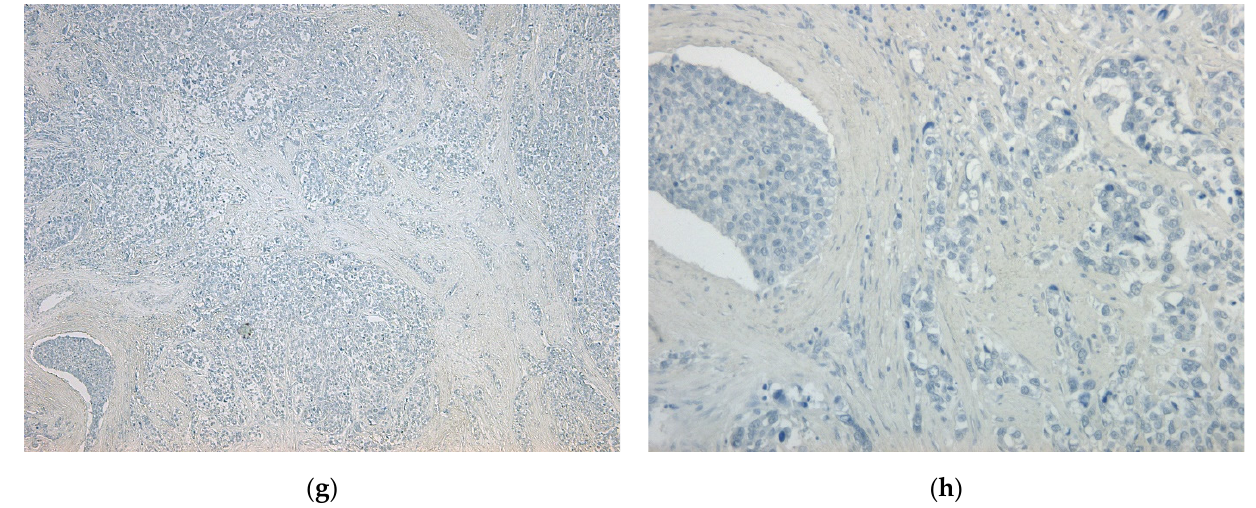
Figure 1. Immunohistochemical staining of TNBC tissue with MAb IV/18 versus M75 versus EP161. ( a ) MAb IV/18 diluted 1:100, magnification ∑ 50×; ( b ) MAb IV/18 diluted 1:100, magnification ∑ 200×; ( c ) M75 diluted 1:1000, magnification ∑ 50x; ( d ) M75 diluted 1:1000, magnification ∑ 200×; ( e ) EP161 diluted 1:100, magnification ∑ 50×; ( f ) EP161 diluted 1:100, magnification ∑ 200×; ( g ) negative control—IHC staining without antibody, magnification ∑ 50×; ( h ) negative control—IHC staining without antibody, magnification ∑ 200 ×